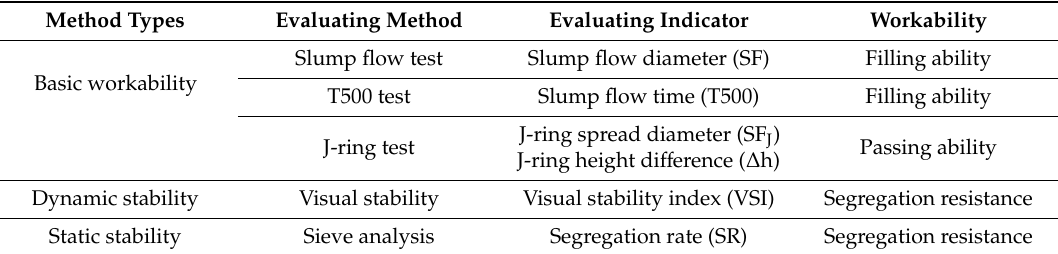
Table 10. Test and evaluation method of workability for